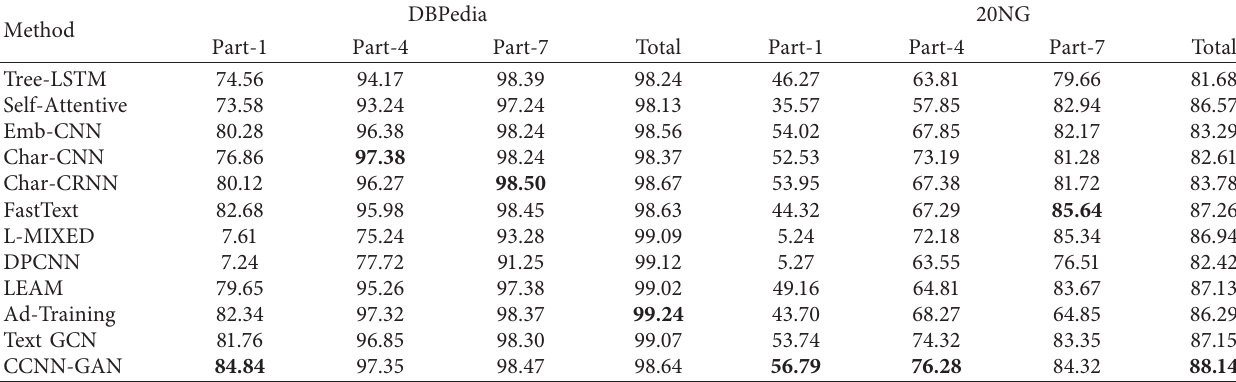
Table 5: Test performance on the DBPedia and 20NG classification task.